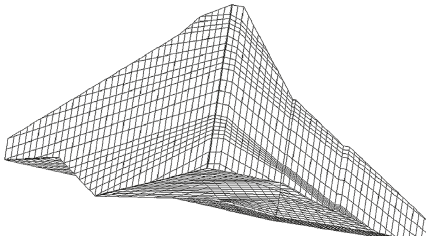
Figure 14: Dam finite element computation grid.